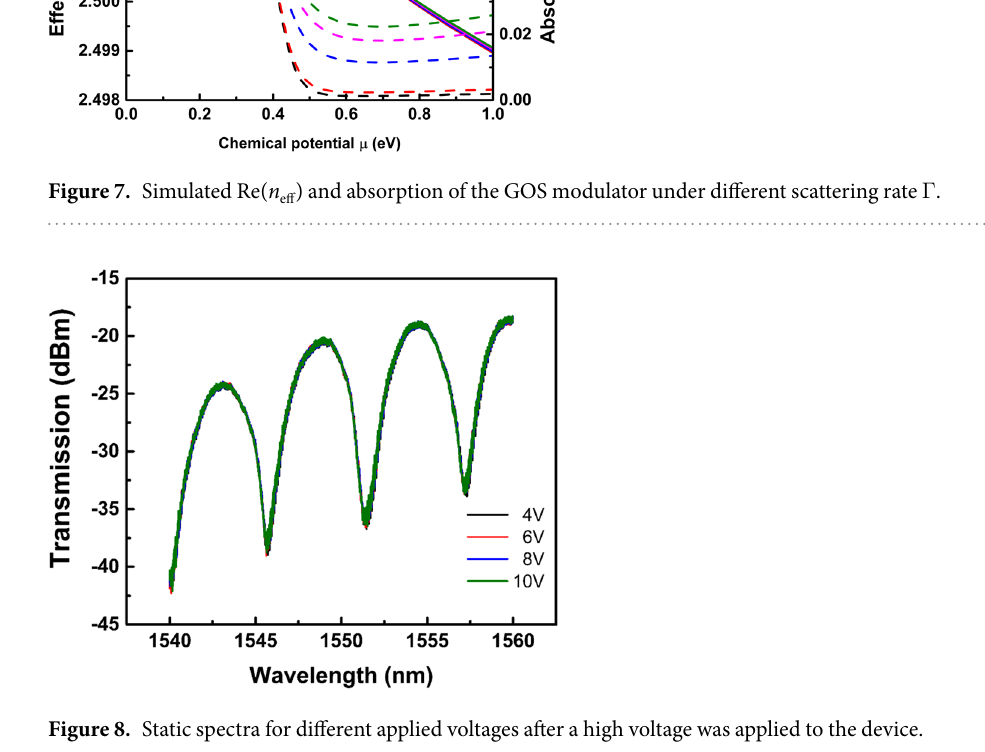
Figure 8. Static spectra for different applied voltages after a high voltage was applied to the